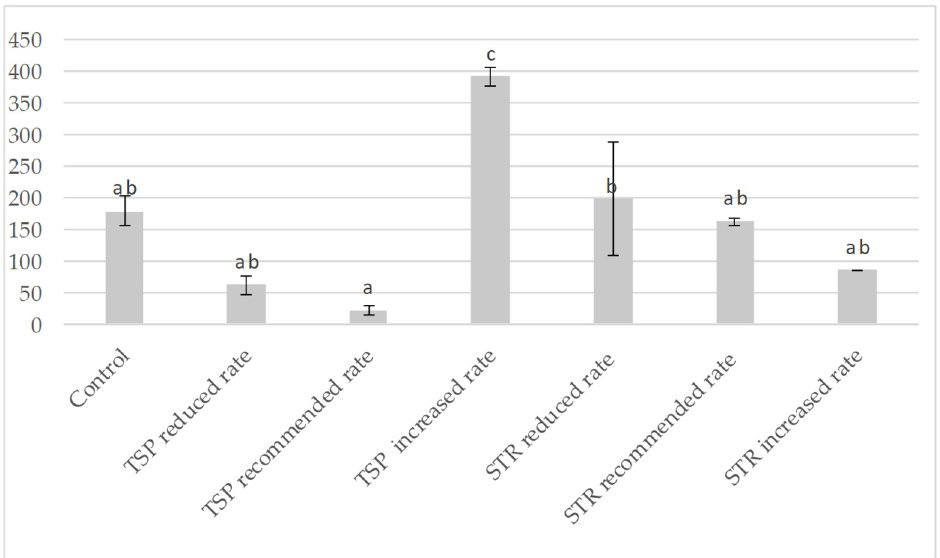
Figure 2. Phosphorus uptake by butterhead lettuce leaves (mg) as affected by the interaction of examined factors (A × B) at the level of significance α = 0.05 ( p value < 0.05).